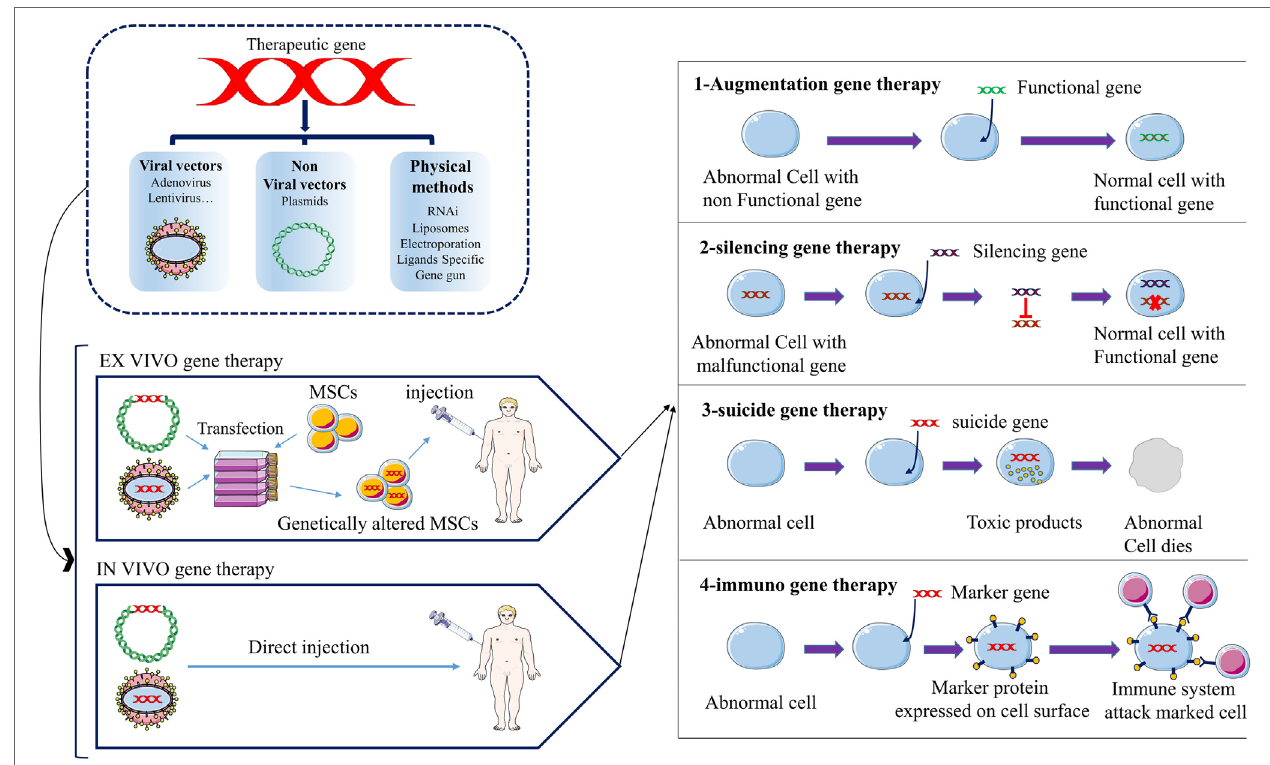
FiGURe 1 | The schematic picture represents the strategies of anticancer gene therapy using mesenchymal stromal/stem cells (MSCs) as gene vehicles. Anticancer gene can be transferred into MSCs by three main groups of techniques; viral vectors, non-viral vectors, and physical methods. There are two approaches for gene therapy of cancer patients; ex vivo , in vivo . Four groups of anticancer gene therapies have been developed to date; augmentation-, silencing-, suicide-, and immune-gene